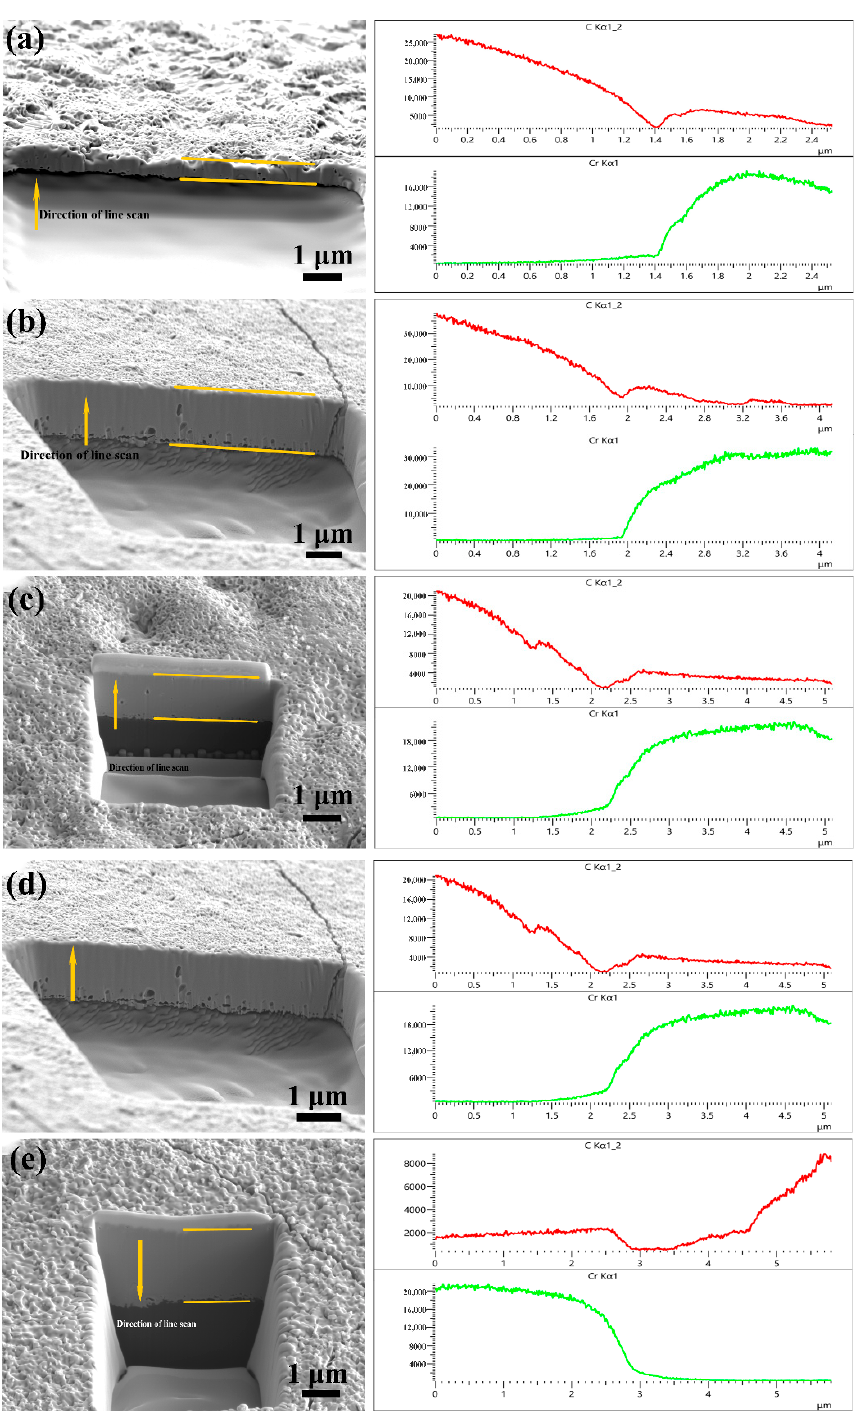
Figure 3. Micromorphology and EDS linear analysis of the coating with various coating